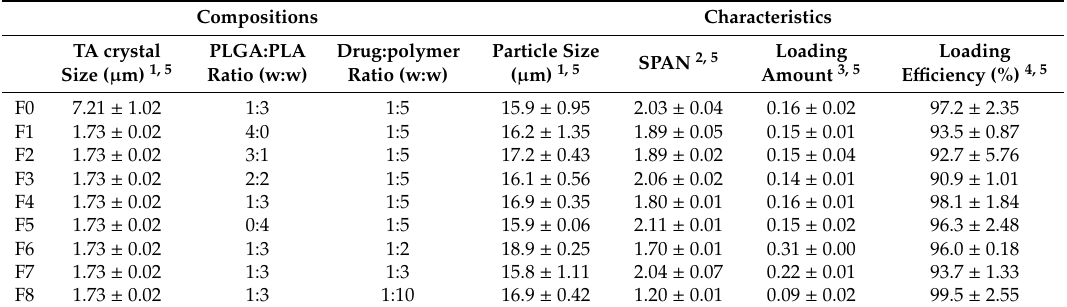
Table 2. Compositions and physicochemical characteristics of TA microcrystals-loaded MSs. Compositions Characteristics TA crystal Size ( µ m)